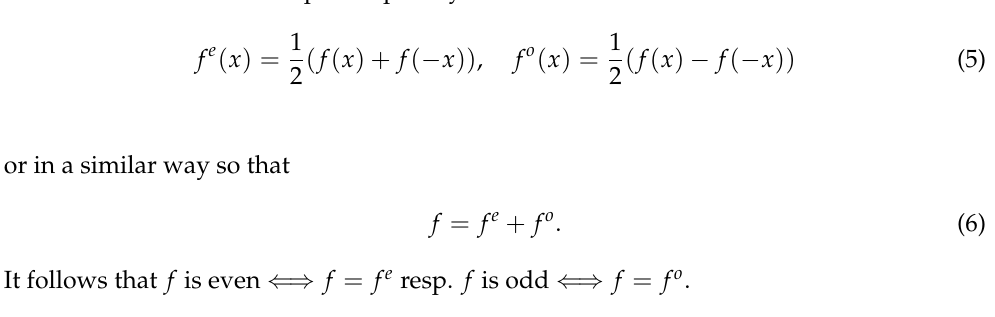
Table 1. Parity and ingredients. objects odd even character odd even quadratic field imaginary real function Bernoulli polynomial Clausen function class number relative class number classumber of max. real subfield determinant Maillet Maillet with Clausen